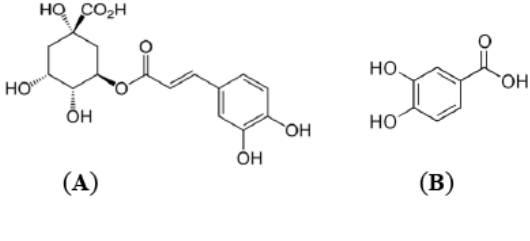
Figure 1. The most frequent phenolic acids—( A ) chlorogenic acid; ( B ) protocatechuic acid, in Chinese hawthorn